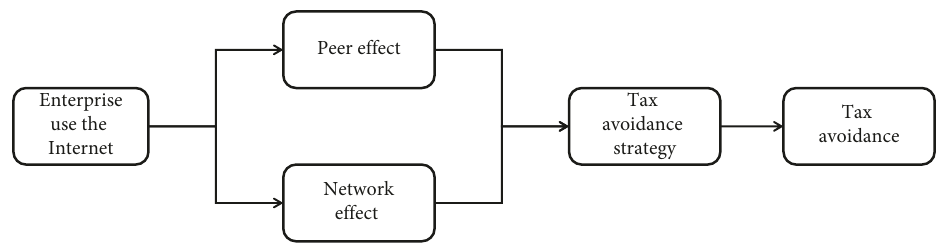
Figure 1: The impact path of Internet use by enterprises to increase tax